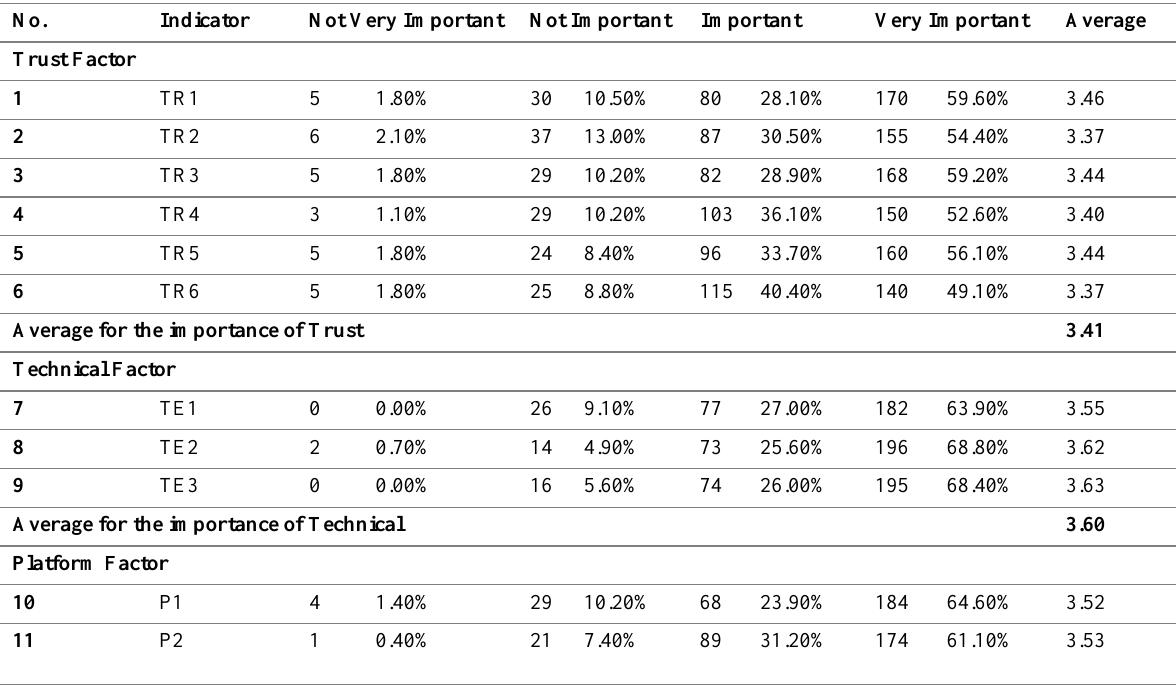
Table 2: Responses and Average of the Importance